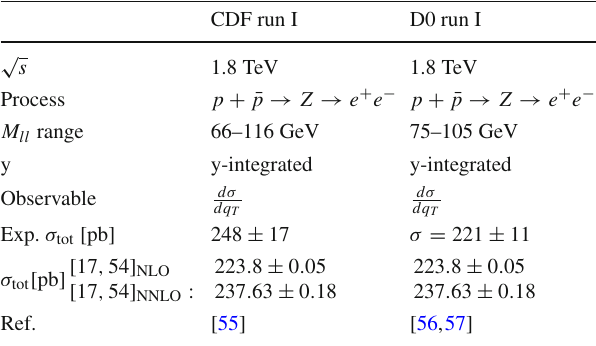
Table 4 The characteristics of the data measured at CDF and D0 col- laborations at run 2 CDF run II D0 run II √ s 1.96 TeV 1.96